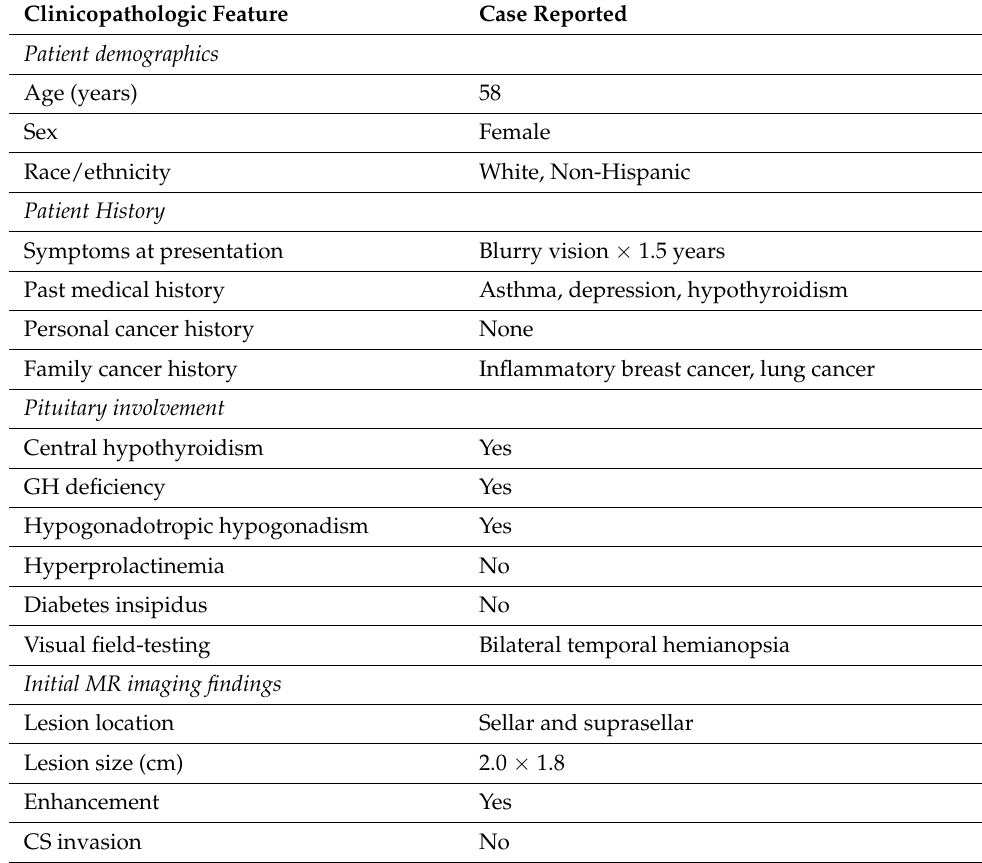
Table 1. Summary of clinical, biochemical, radiologic, and histologic findings of the reported case. Abbreviations: GH growth hormone, MR magnetic resonance, CS cavernous